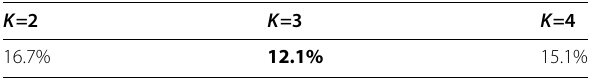
Table 3 Results of different parameter K